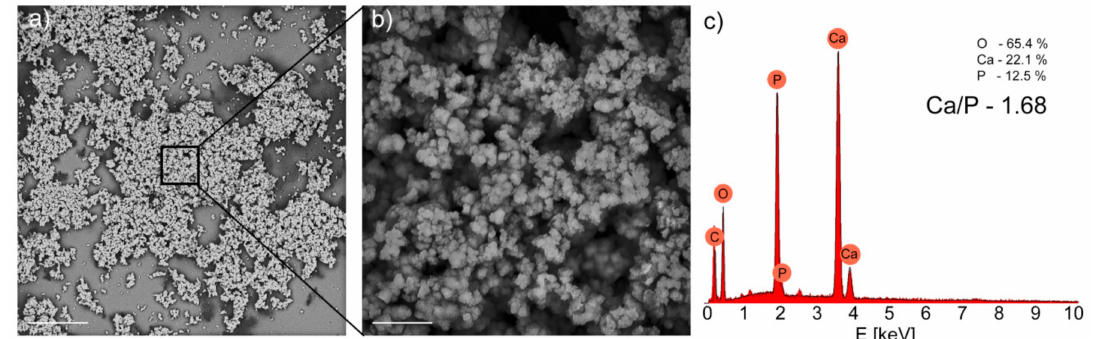
Figure 3. SEM images of the Ag-SiO 2 that functionalize NiTi surfaces, obtained after a three-week incubation in a simulated body fluid. Scale bars—( a ) 100 µ m and ( b ) 20 µ m. ( c ) EDS spectrum with the atomic concentration values for oxygen, calcium, and phosphorous with a Ca/P ratio that was estimated based on the chemical